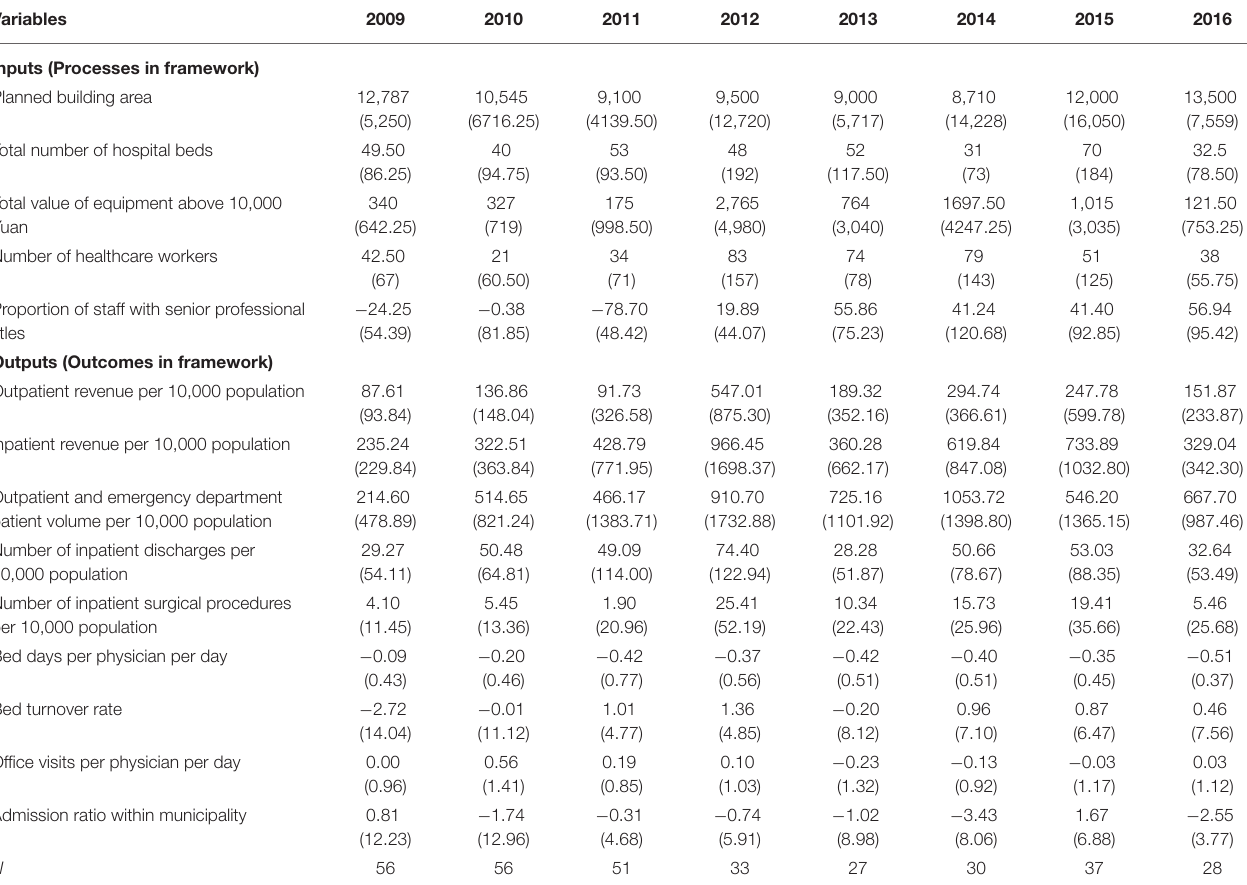
TABLE 2 | Descriptive statistics of inputs and outputs.